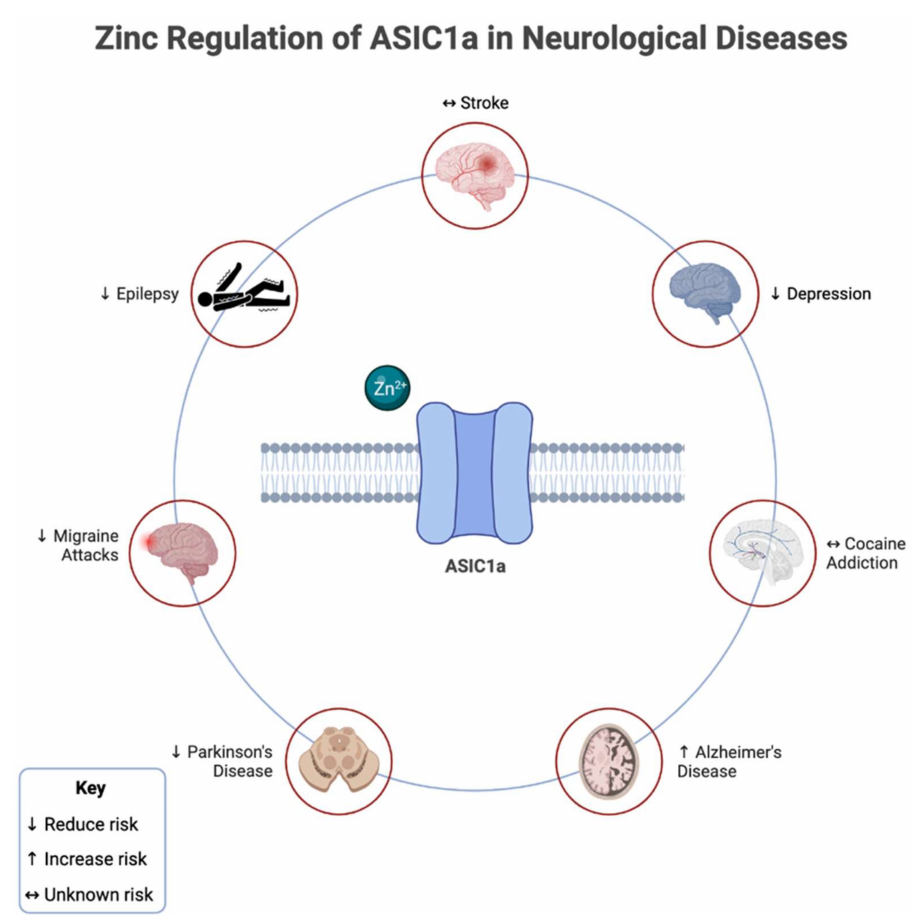
Figure 2. Zinc Regulation of ASIC1a in Neurological Diseases. Zinc-mediated inhibition of ASIC1a channels is theorized to reduce the risk of epilepsy, migraine attacks, Parkinson’s disease, and depression and increase the risk of Alzheimer’s disease. Its effects on cocaine addiction and strokes are unknown based on current literature. Adapted from “Transporters” by BioRender.com (2022) (https://app.biorender.com/biorender-templates, accessed on 28 December